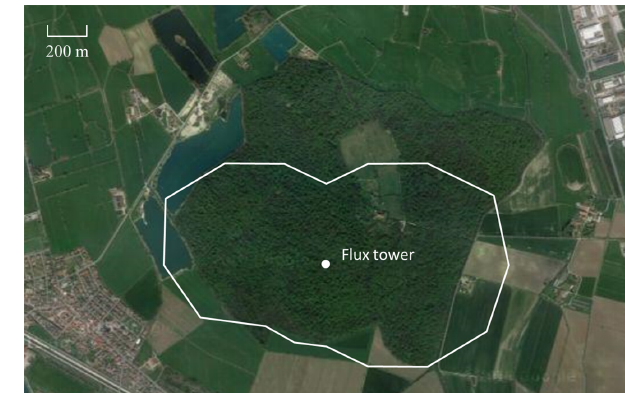
Figure 2. Satellite image (map data © Google 2016) of the field site showing the flux tower and footprint containing 80% of the flux measured during the campaign (13 June–11 July